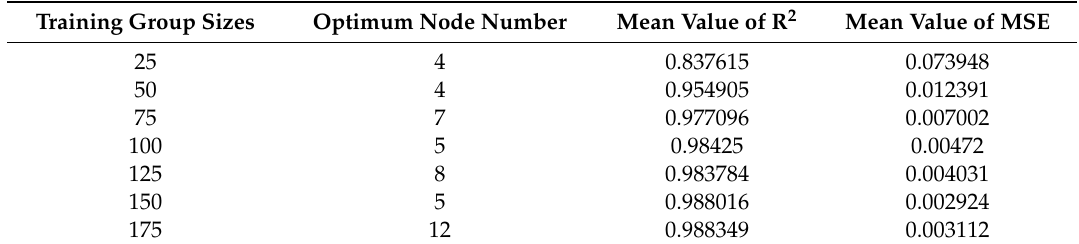
Table 9. The optimum node number, corresponding R 2 and mean square error (MSE) of different training group sizes.